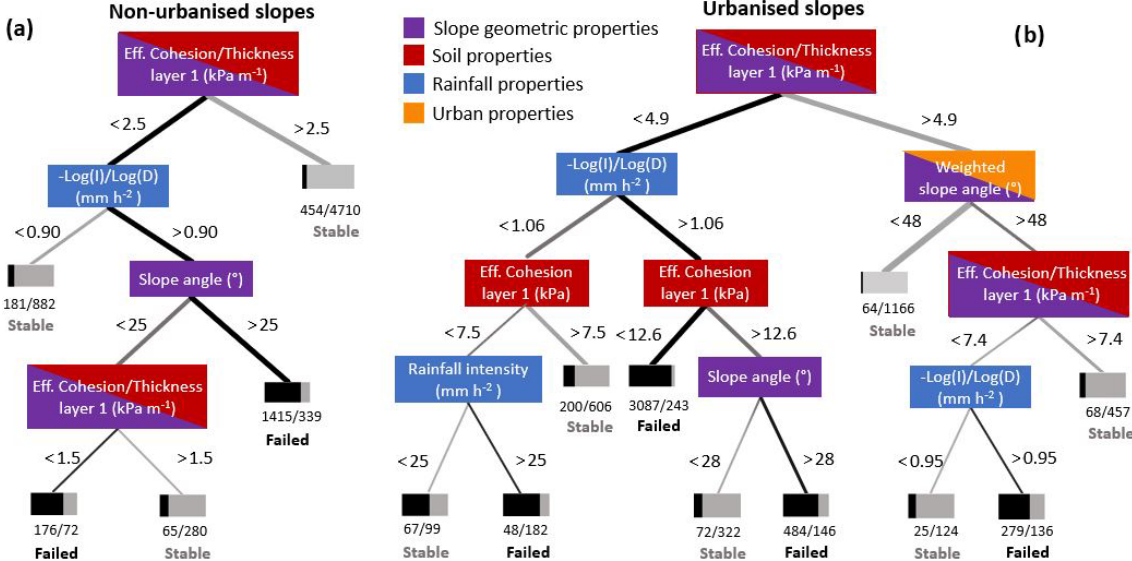
Figure 8. Classification tree of slope response for non-urbanised slopes (a) and urbanised slopes (b) . Black branches represent the paths that lead to simulations predicted as failed, while grey branches lead to simulations predicted as stable. The bar under each leaf shows the proportion of simulations that were failed (black) or stable (grey) for that leaf. The thickness of the branch is proportional to the number of simulations following that path. Note that 14% and 22% of the simulated slopes have been excluded, respectively, for the non-urbanised and urbanised case because they failed before the start of the